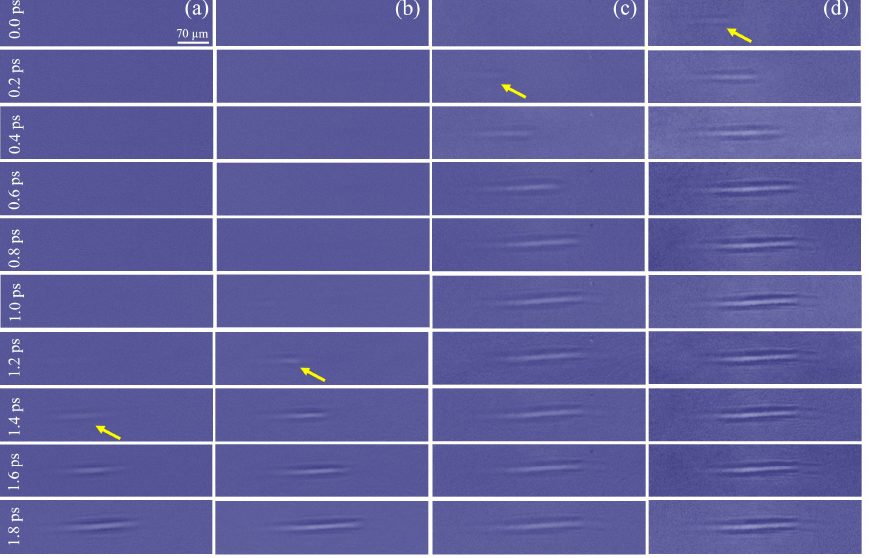
Figure 3. Time evolution of a femtosecond pulse laser-induced air plasma filament under different probe pulses at ( a ) 800-o; ( b ) 800-e; ( c ) 400-o, and ( d ) 400-e. The yellow arrow indicates the initial formation of air plasma fi lament.